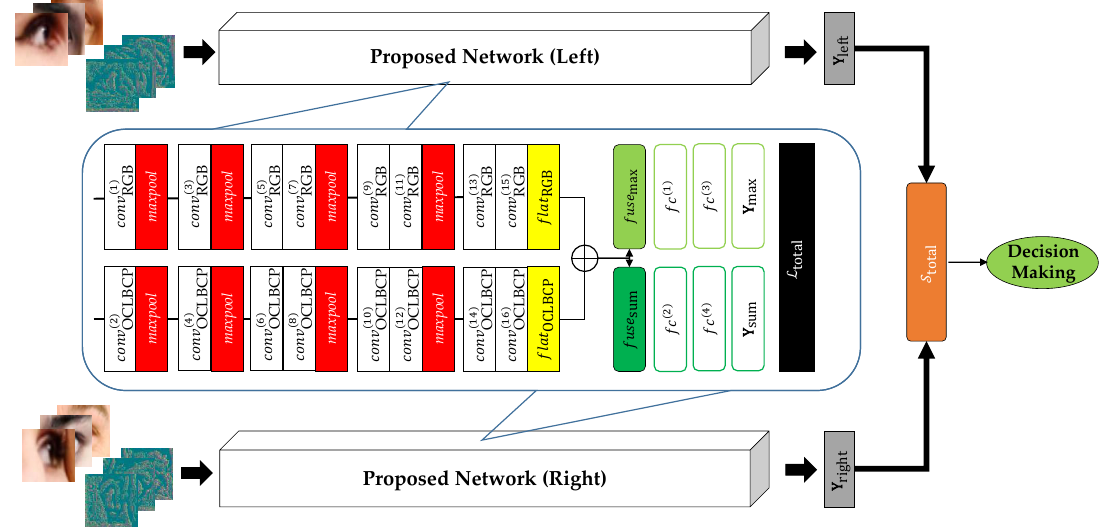
Figure 3. The architecture of the proposed